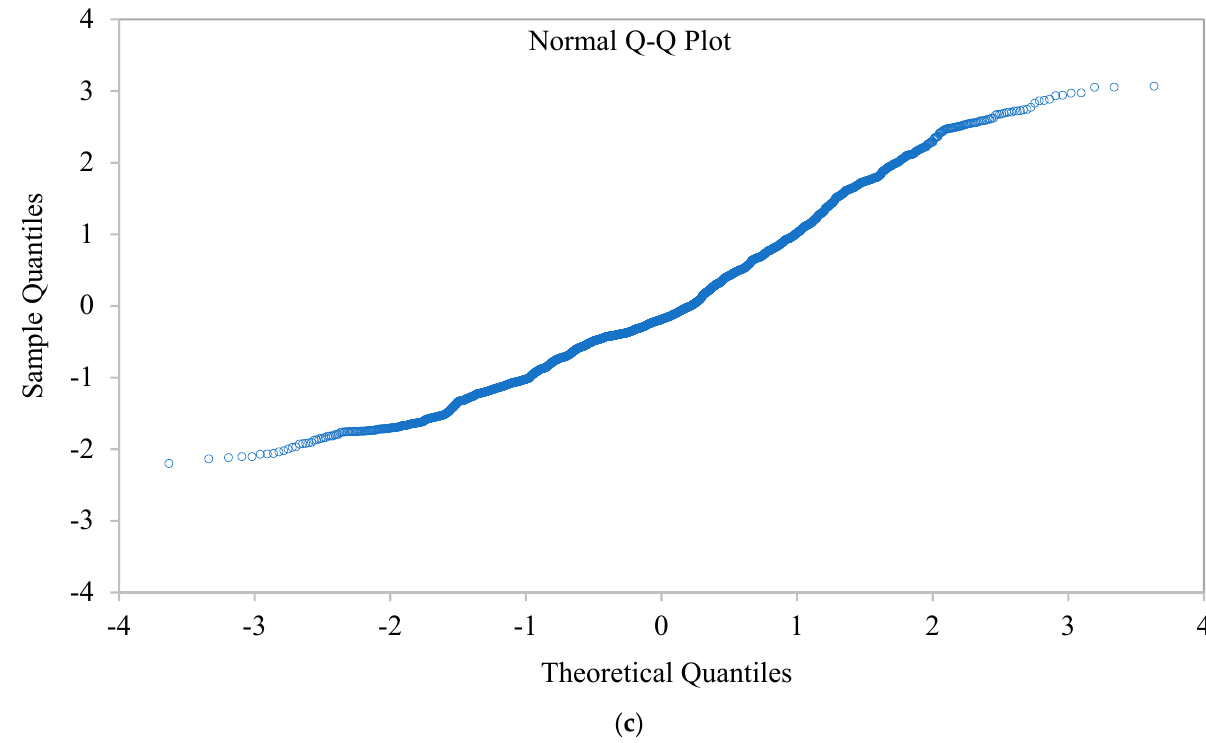
Figure 2. Evolution of the daily price trajectories of Bitcoin from 13 September 2011 to 24 June 2021, along with the regression line: ( a ) Bitcoin daily price trajectories and regression line; ( b ) externally studentized residuals versus the corresponding fitted logarithm value of Bitcoin price; ( c ) the normal Q-Q plot of the externally studentized residuals